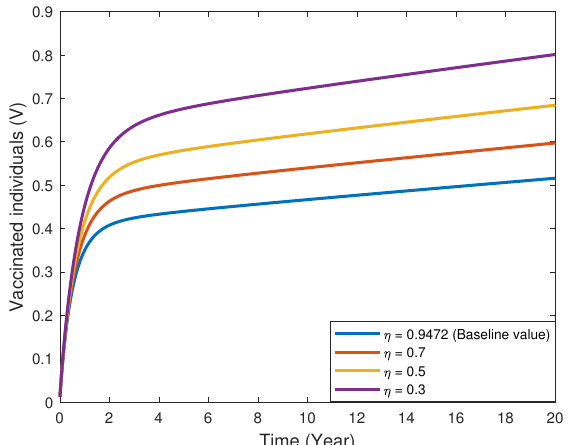
Figure 20. Behavior of V class for different η